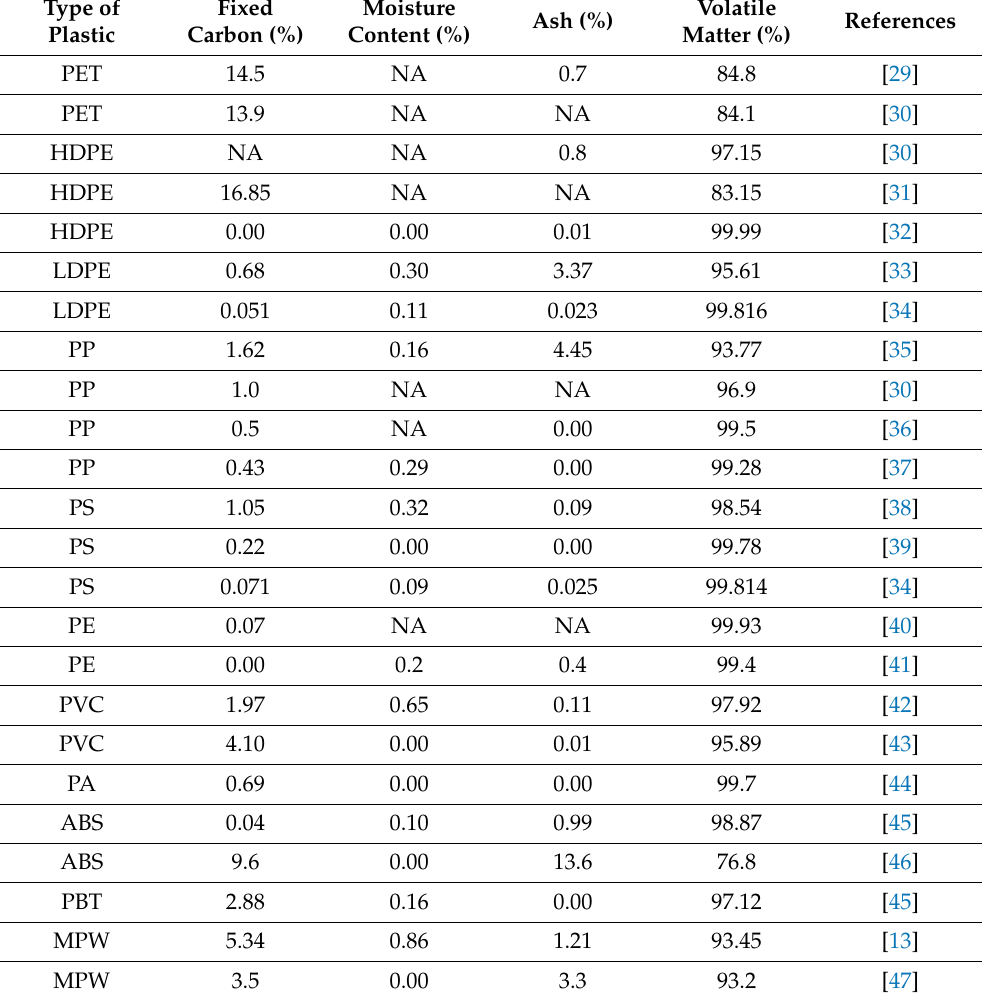
Table 1. Proximate analysis of different type of plastic